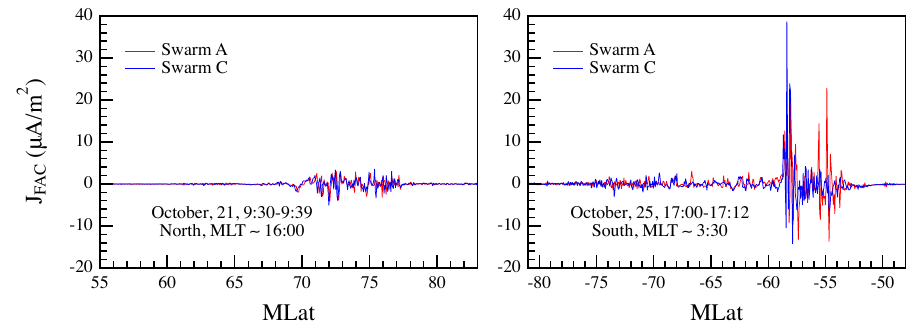
Figure 3. The FAC density, J FAC , for two crossings of the Northern and Southern Hemispheres during the two selected days. The selected high-latitude ionospheric crossings are at the lowest values of the AL index for the two